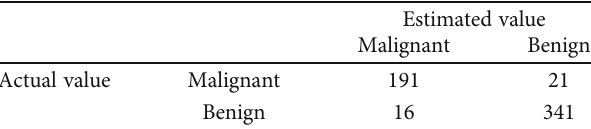
Figure 3: Data of the Naive Bayes technique. Table 2: The complexity matrix of the Naive Bayes